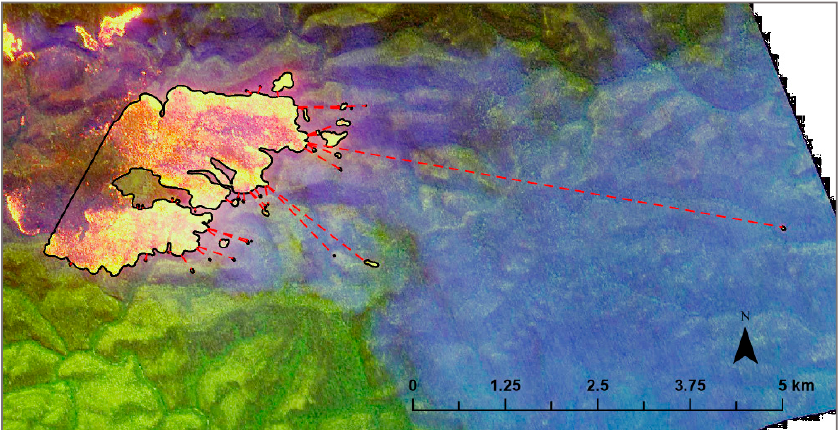
Figure 3. RFS line scan showing individual source fire (largest polygon) and spot fires (small polygons). Interpretation as in Figure 2. Fire 2020 , 3 , x FOR PEER REVIEW